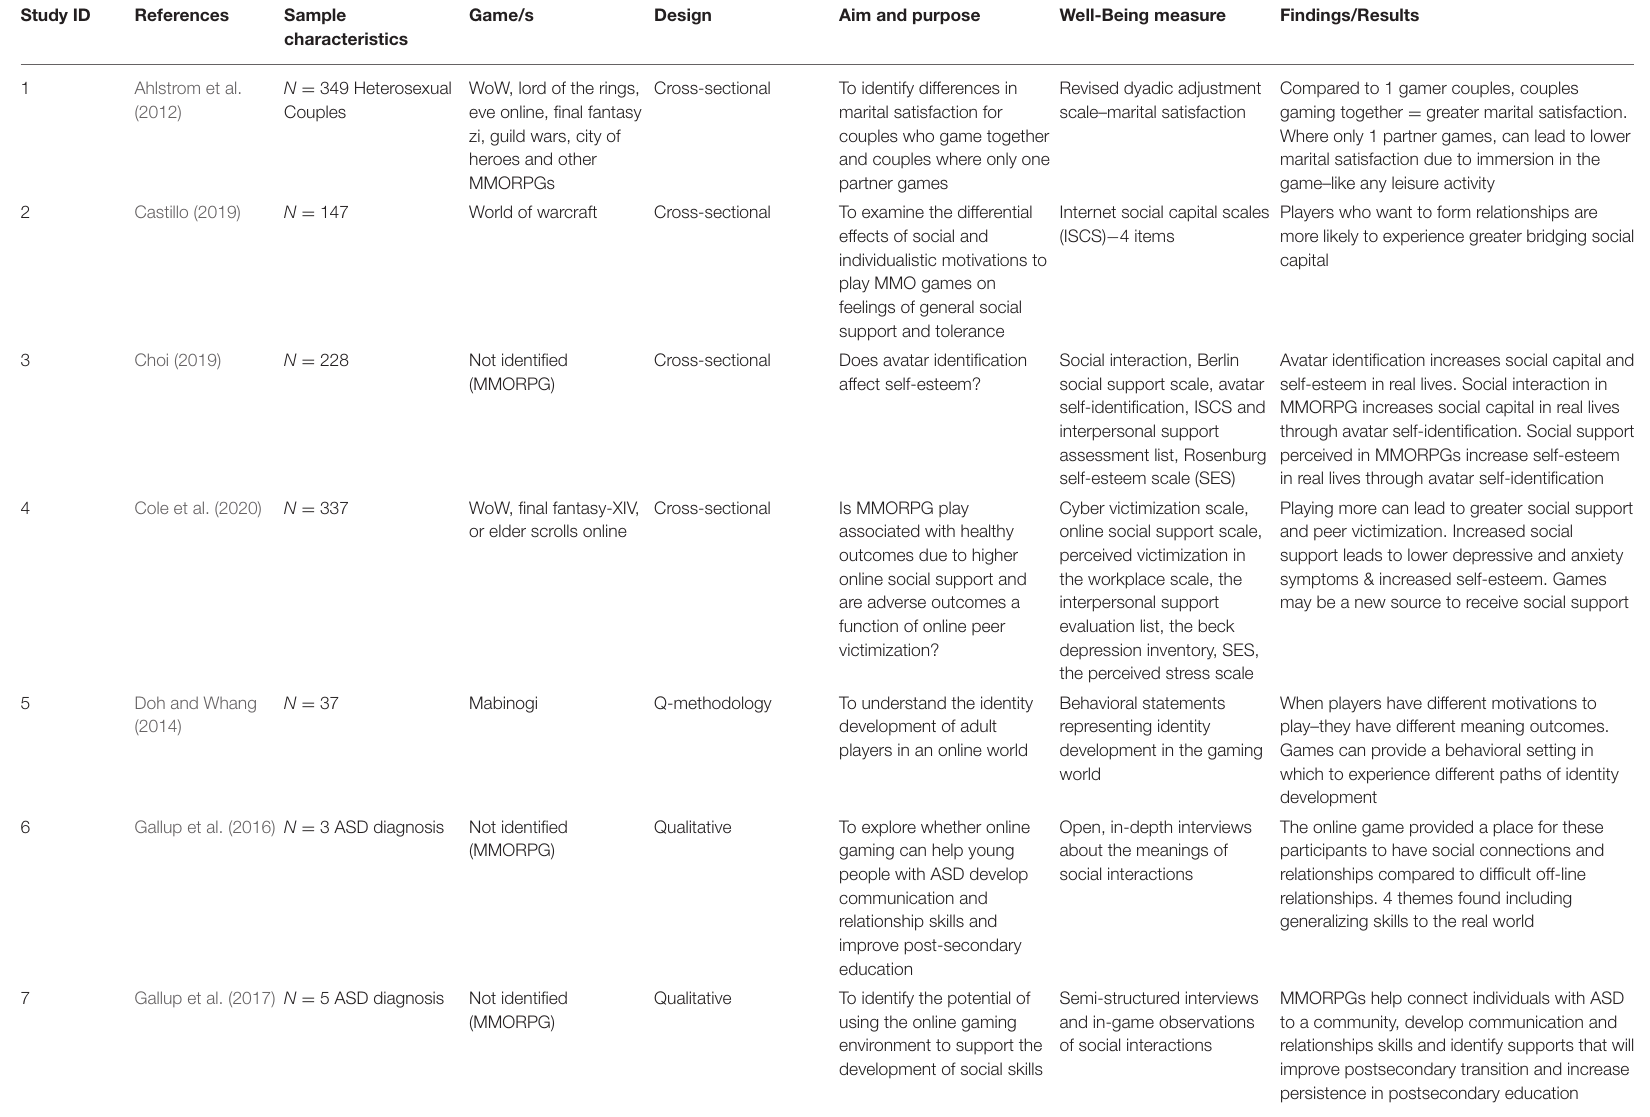
TABLE 1 | Main characteristics of reviewed studies ( N =